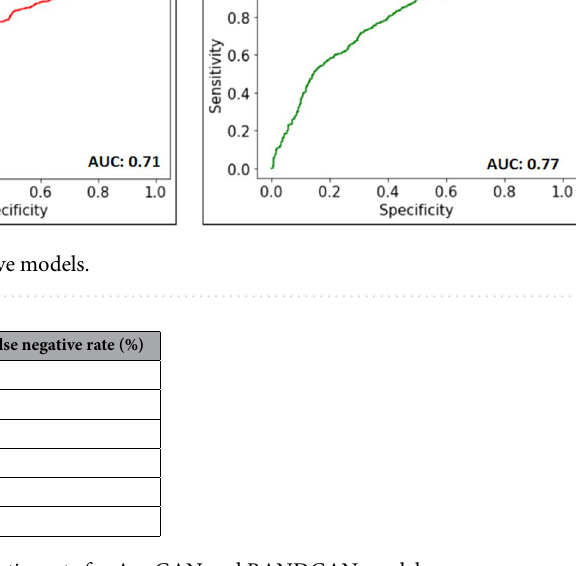
Table 3. Sensitivity, specificity and false negative rate for AnoGAN and RANDGAN